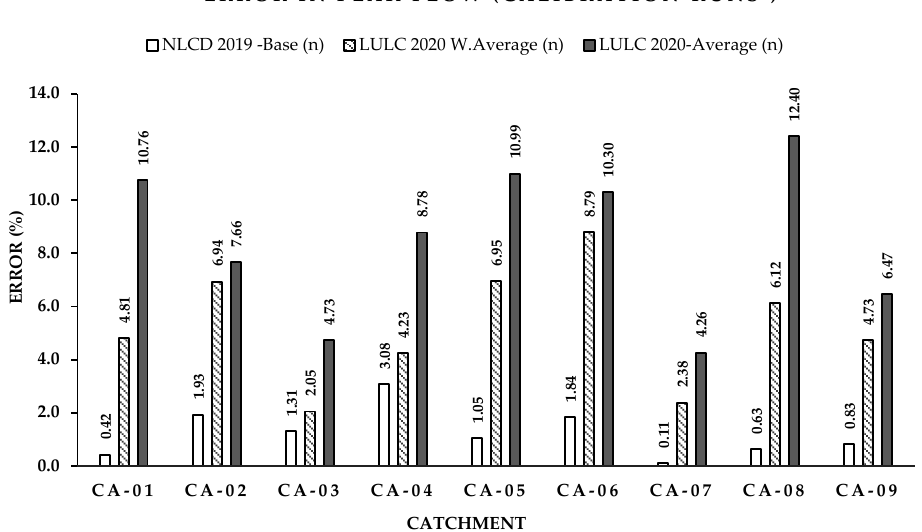
Figure 12. Peak-flow error using LULC 2020-ESRI along with ( n avg ) and ( n w.avg ) values compared to the base calibrated results.